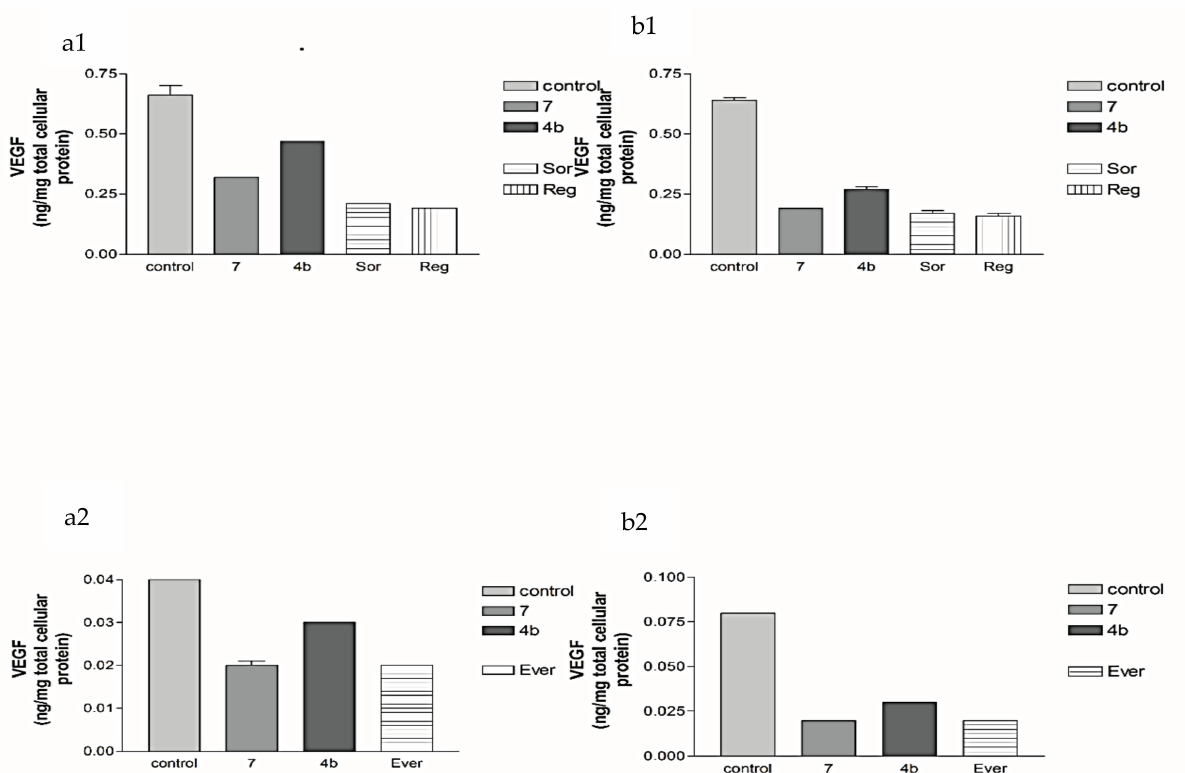
Figure 5. Effects of 7 and 4b and reference medications on VEGF protein expression level (ng/mg tis- sue protein) in HEPG2 and MCF-7, where ( a1 , a2 ) at 24 h and ( b1 , b2 ) 72 h, all therapies were